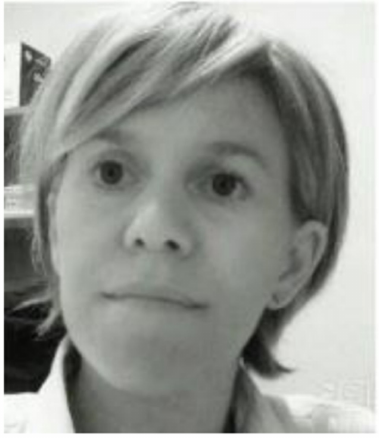
Figure 3. Rossella